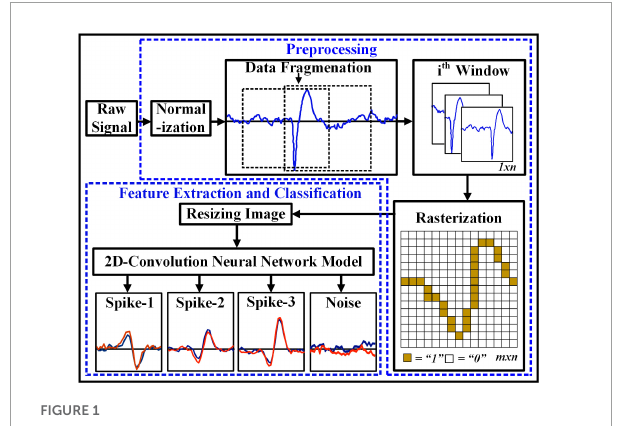
FIGURE1 Overall block diagram of the proposed framework for neural spikes classification.